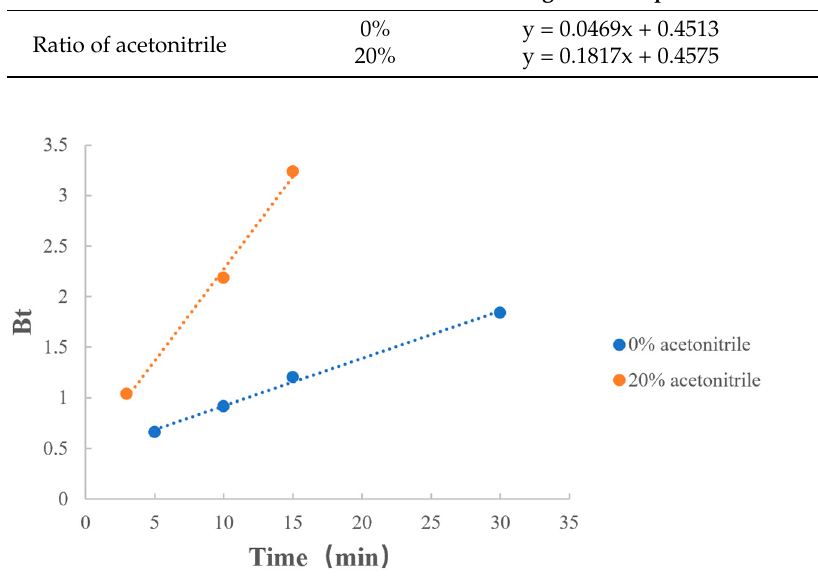
Figure 11. Boyd model fitting on the ratio of acetonitrile.